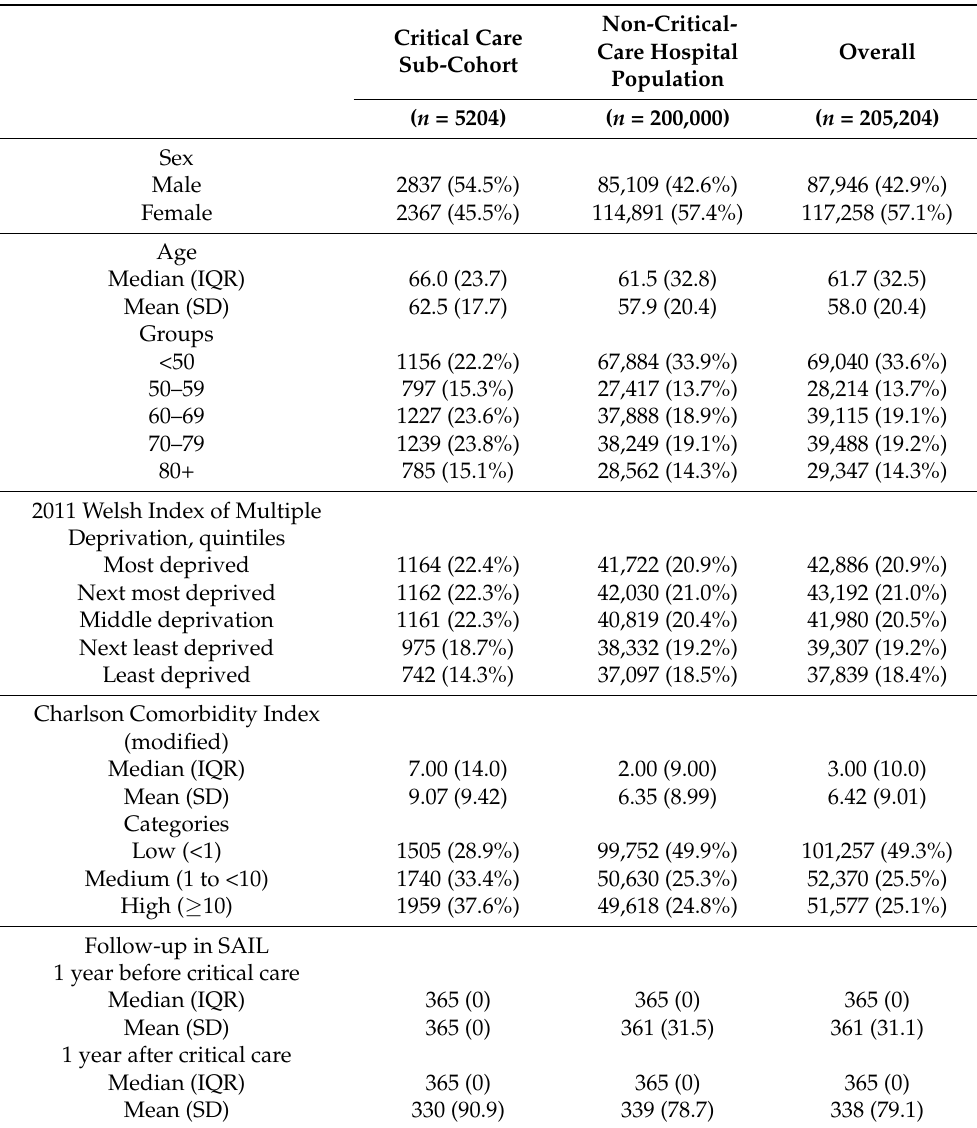
Table 4. Characteristics of the critical care cohort and the non-critical inpatient cohort in